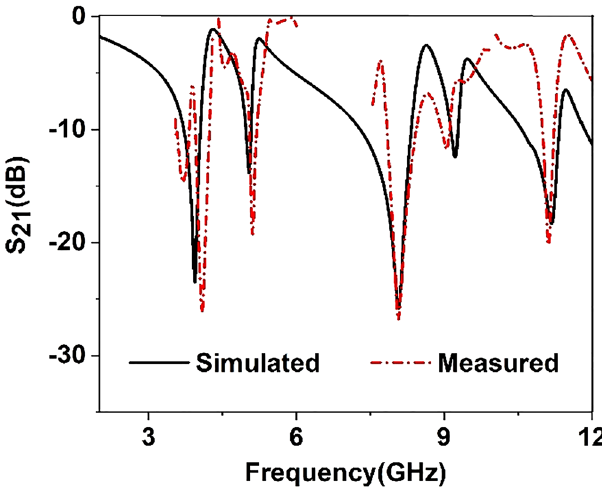
Figure 14. Simulated and Measured result of S 21 .